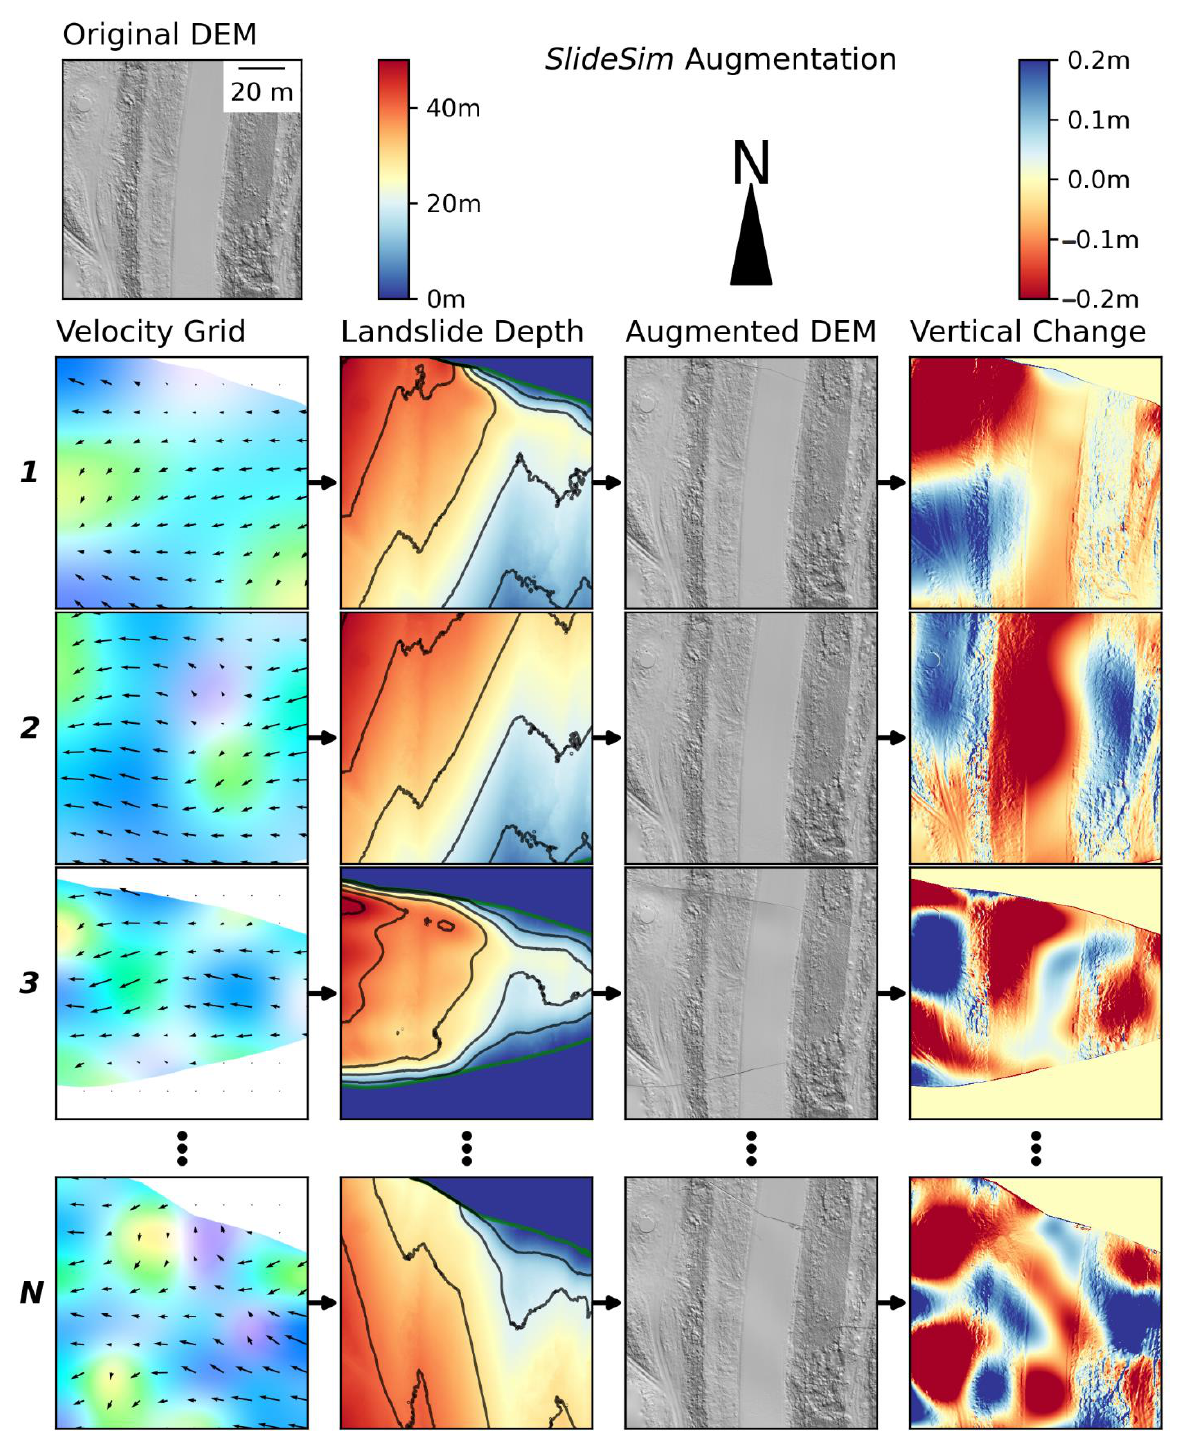
Figure 1. Examples of SlideSim augmentation, showing the augmentation of the original DEM for several velocity grid, landslide boundary, and slip surface combinations. The numbers of coarse grid points used to generate each of the velocity grids are 9, 16, 25, and 36 for rows 1, 2, 3, and N, respectively. Velocity vector magnitude/direction is indicated by quiver arrows (scaled 20 × ) as well as background color (blue= substantial movement, green/yellow = intermediate, purple = small).